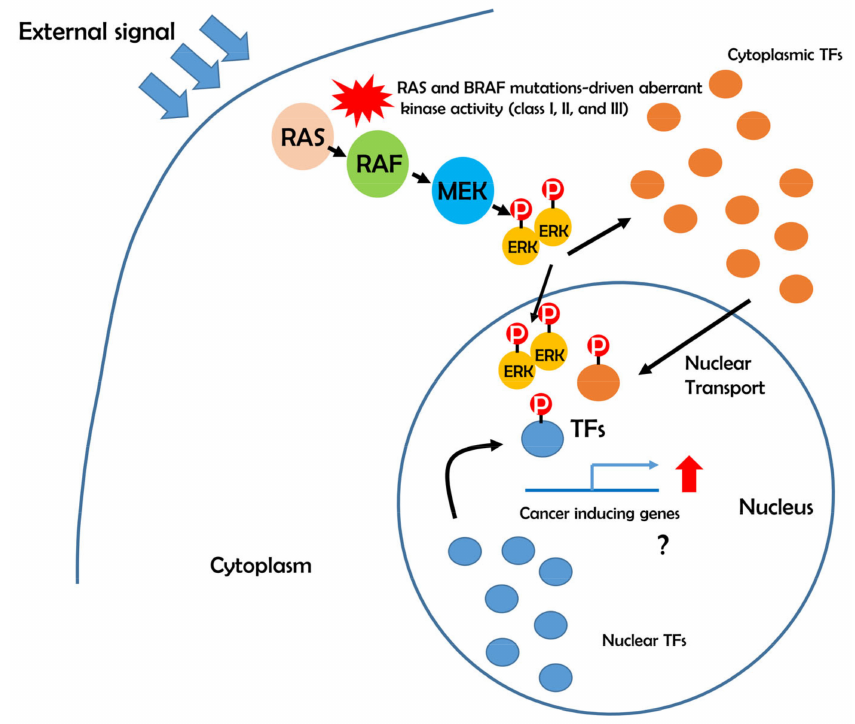
Figure 3. Transcription factors modulated by the ERK signaling pathway are possible downstream targets of di ff erent classes of BRAF mutations. Phosphorylated transcription factors exert their transcriptional activity in the nucleus and stimulate the cancer-inducing target gene